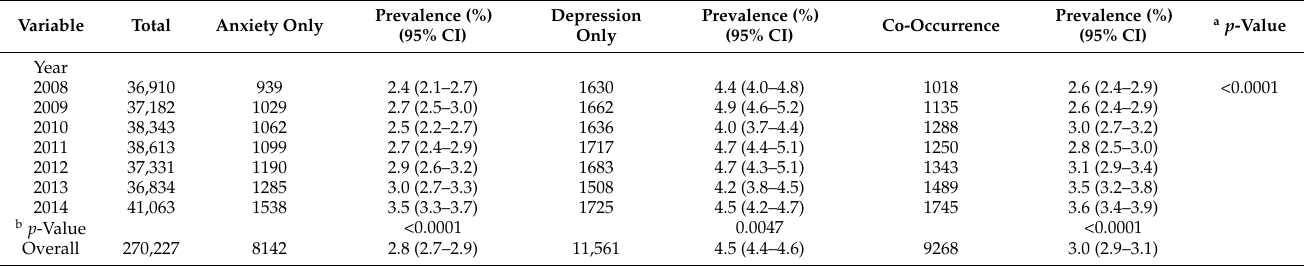
Table 2. Prevalence of anxiety only, depression only, and their co-occurrence by year